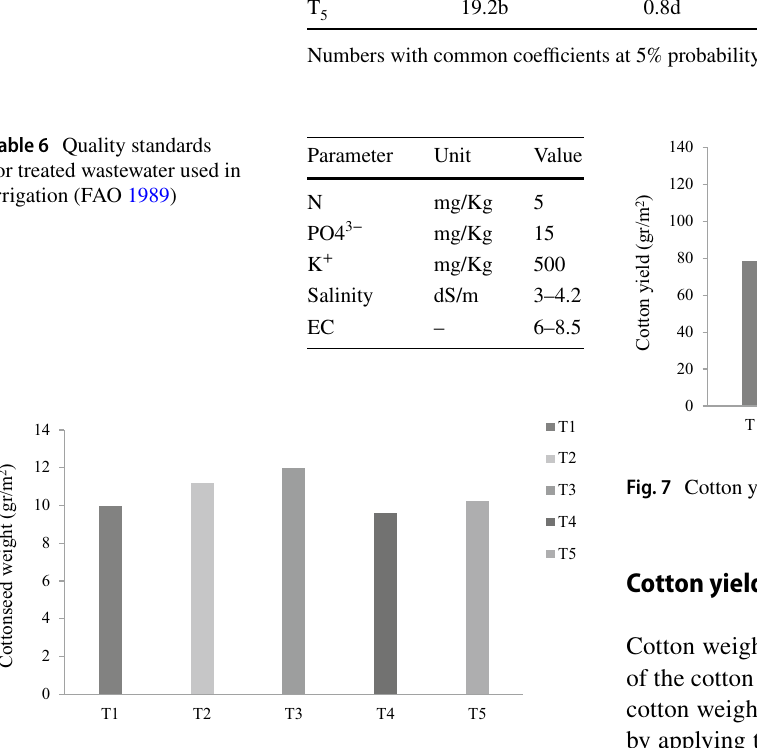
Table 5 Mean comparison of each soil chemical parameter between the experimental treatments (at a depth of 0–40 cm)